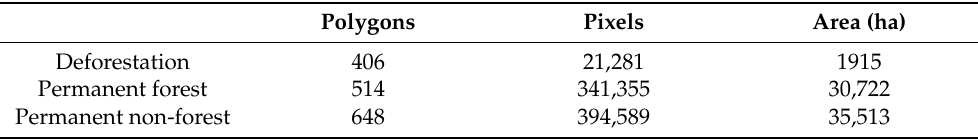
Table 2. Number of polygons, pixels, and corresponding area for deforestation, permanent forest, and permanent non-forest sites at Rio